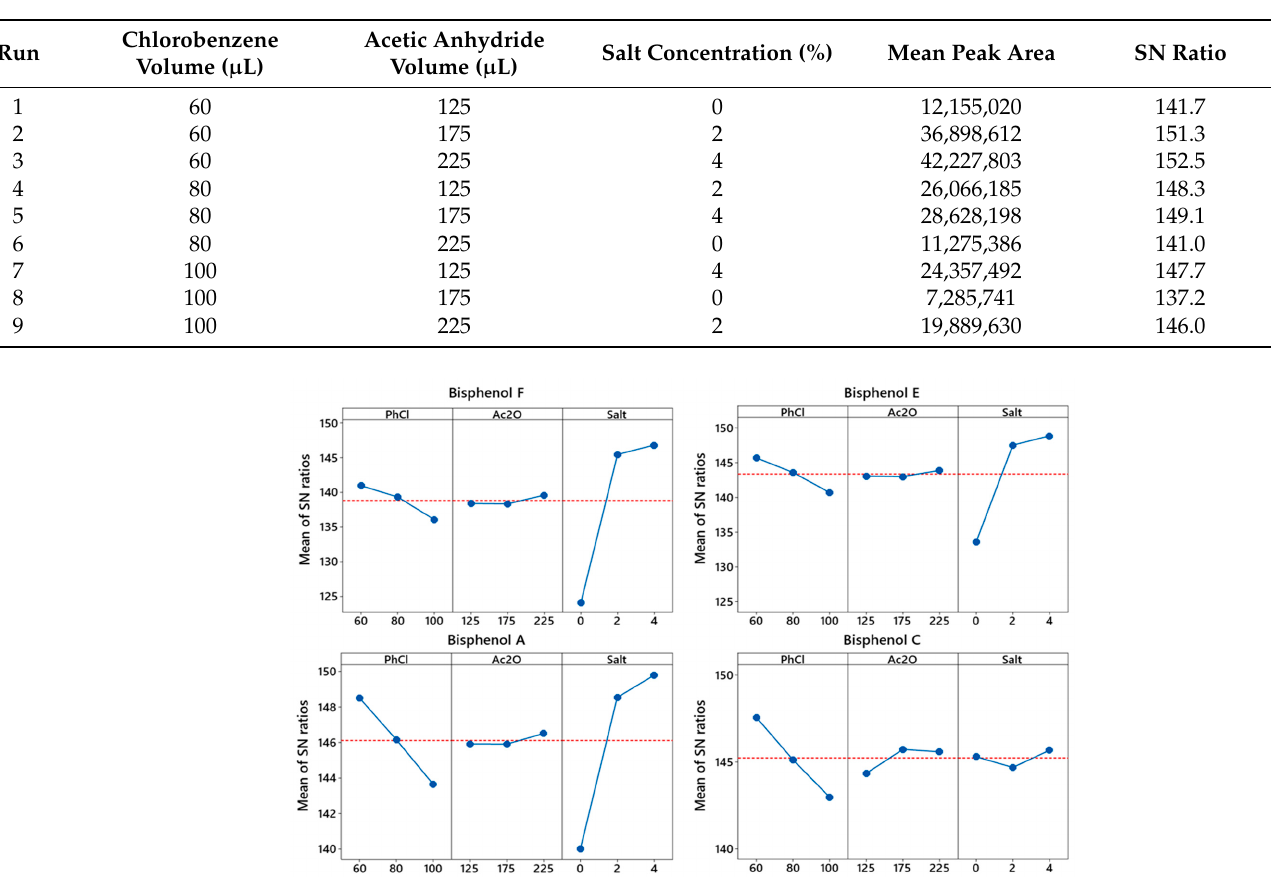
Table 2. Taguchi orthogonal array for BPA.